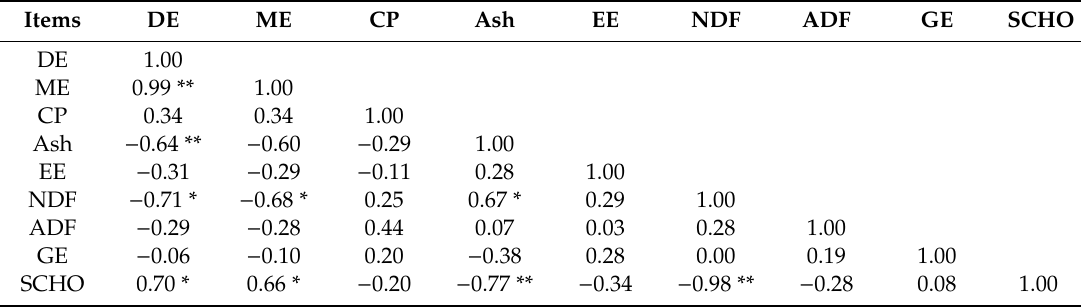
Table 9. Correlation coe ffi cients among chemical compositions and energy in the wheat bran 1 .